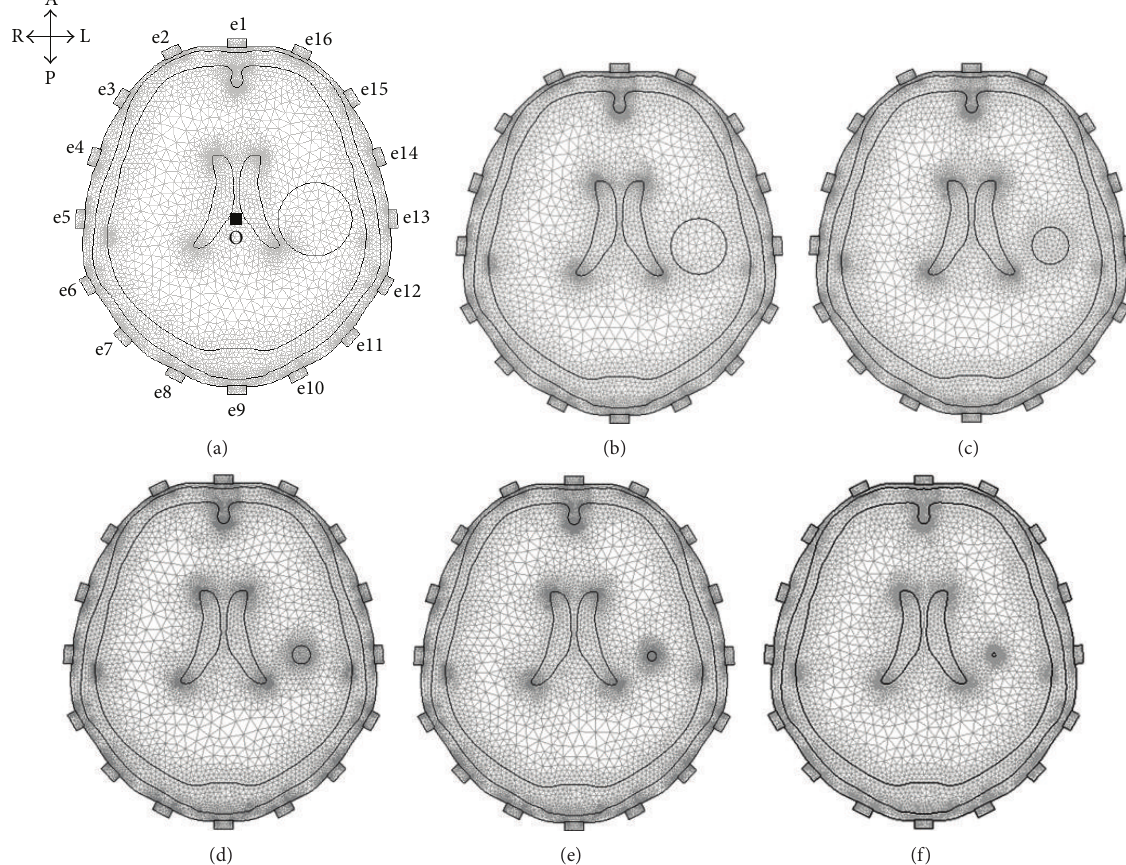
Figure 7: Simulated stroke lesions of different sizes.The radius of the object was set to 2.00, 1.50, 1.00, 0.50, 0.25, and 0.10 cm (from (a) to (f)) (A: anterior; P: posterior; L: left; and R: right). The conductivity of the object was set to 0.65 S/m in the case of simulated hemorrhagic stroke and 0.13S/m in the case of simulated ischemic